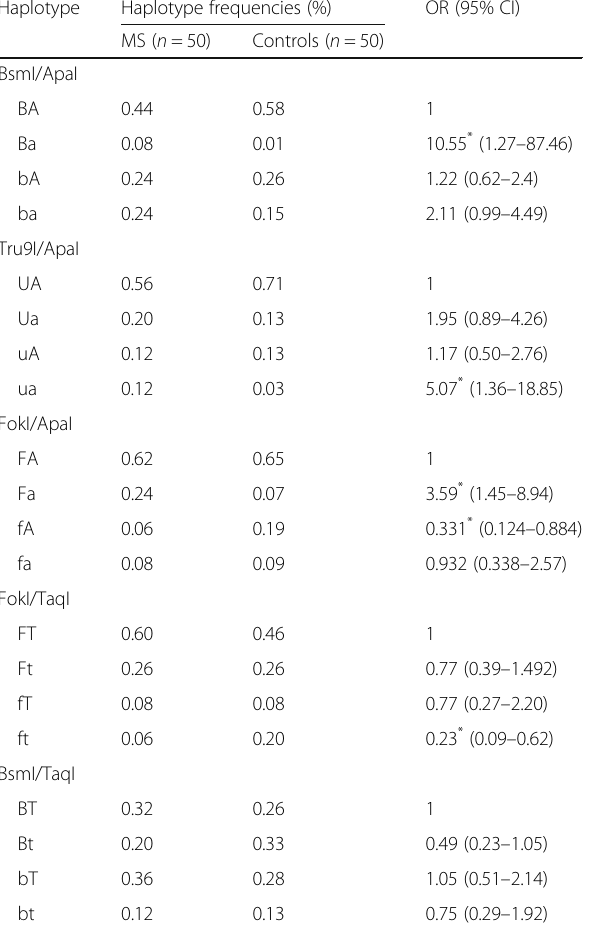
Table 5 Association of tri-allelic haplotypes in the two study groups